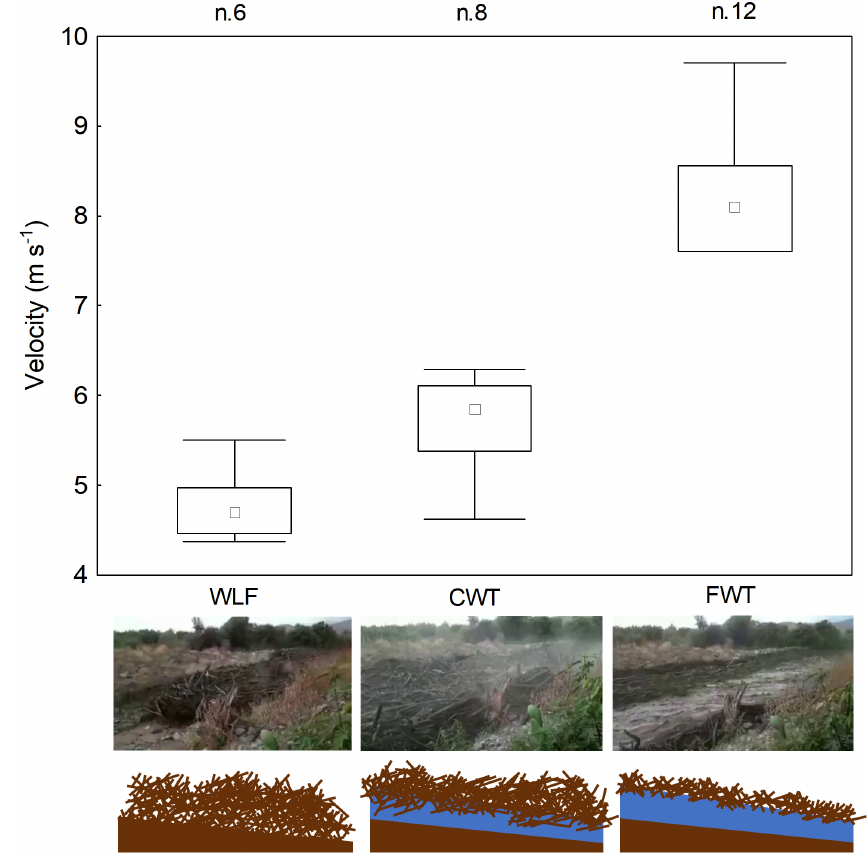
Figure 2. Mean velocity of three different portions of the event: (a) the front of the event, where logs where transported as a dry mass (wood- laden flow; WLF); (b) the middle of the event, where logs were highly congested but clearly floating on water (congested wood transport, CWT) and (c) after the passage of the front, where logs were floating on water (floating wood transport,